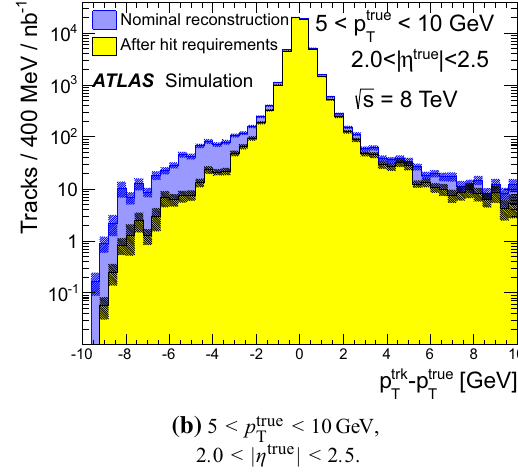
[GeV] true -p trk p T T 2 . 0 < | η true | < 2 . 5. tion of the more stringent silicon detector hit requirements. A simulated < 1000GeV is used, and the statistical dijet sample with 20 < p lead T uncertainties in the number of MC simulated events are shown as a hatched